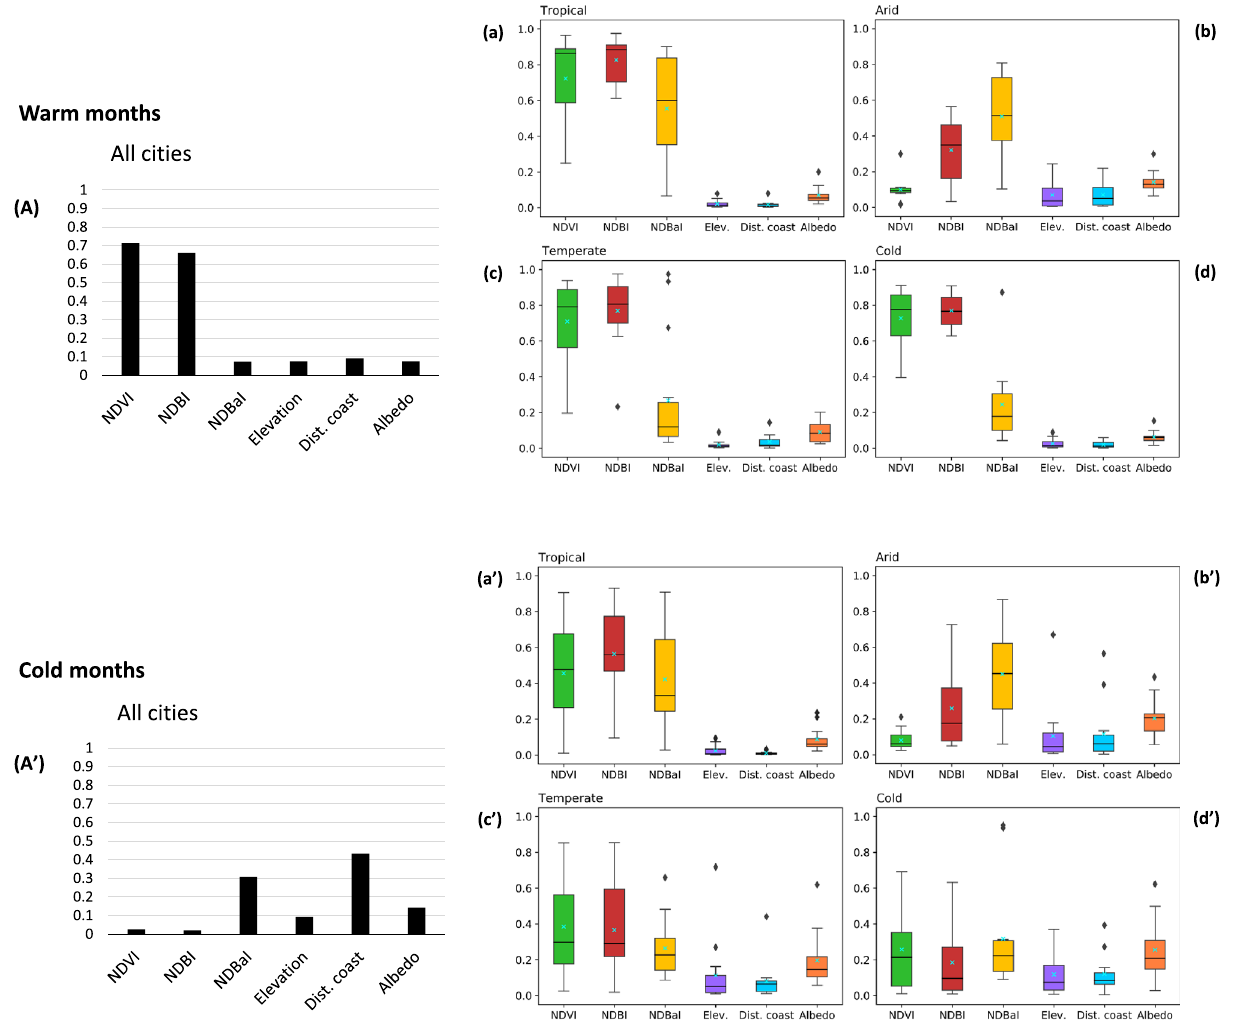
Figure 7. Determinants of LST variability. Predictor feature importance scores extracted from trained GB model explaining the variance in LST during warm months ( A all cities before classifying climate, a tropical cities, b arid cities, c temperate cities, d cold cities) and cold months ( A’ all cities before classifying climate, a’ tropical cities, b’ arid cities, c’ temperate cities, d’ cold